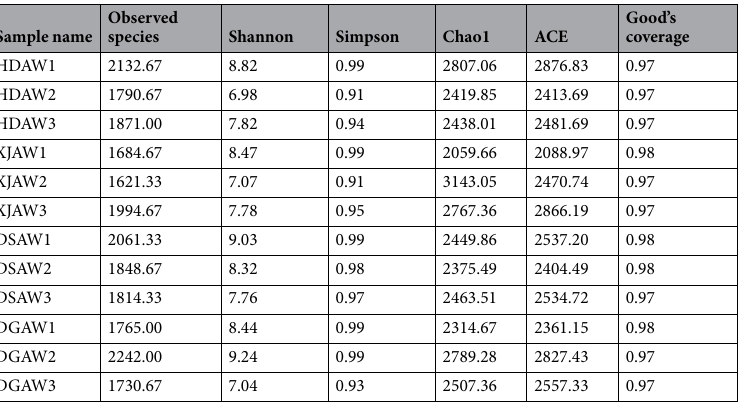
Table 2. Estimated OTU richness and diversity indices of the rhizosphere soil collected from Ferula . L in the northern part of Xinjiang Uygur Autonomous Region of China. Abbreviations: HDAW, F. syreitschikowii ; XJAW, F. gracilis ; DSAW, F. ferulaeoides; and DGAW, F. lehmannii . The numbers indicate the root depth (1, 2, and 3 represent the 3, 20, and 40 cm depths, respectively).